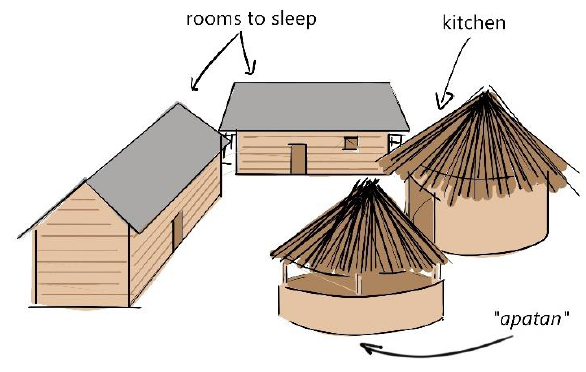
Figure 6. Sketch of adobe house with material disturbances.